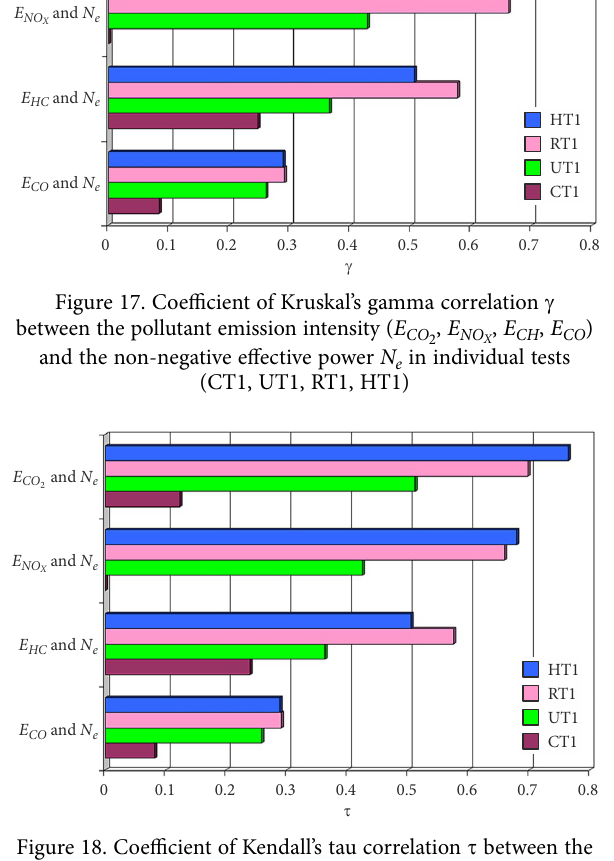
Figure 16. Coefficient of Spearman’s rank correlation R between the pollutant emission intensity ( E CO and the non-negative effective power N e of the engine in individual tests (CT1, UT1, RT1, HT1)